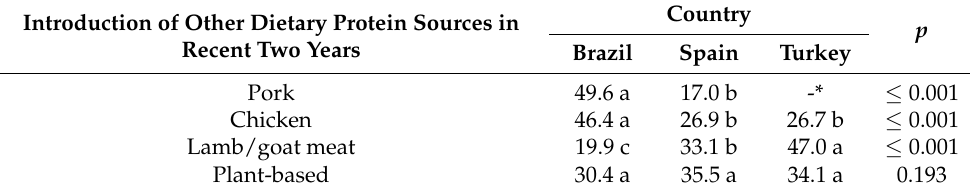
Table 5. Introduction of other sources of protein to replace beef in the Brazilian, Spanish, and Turkish population